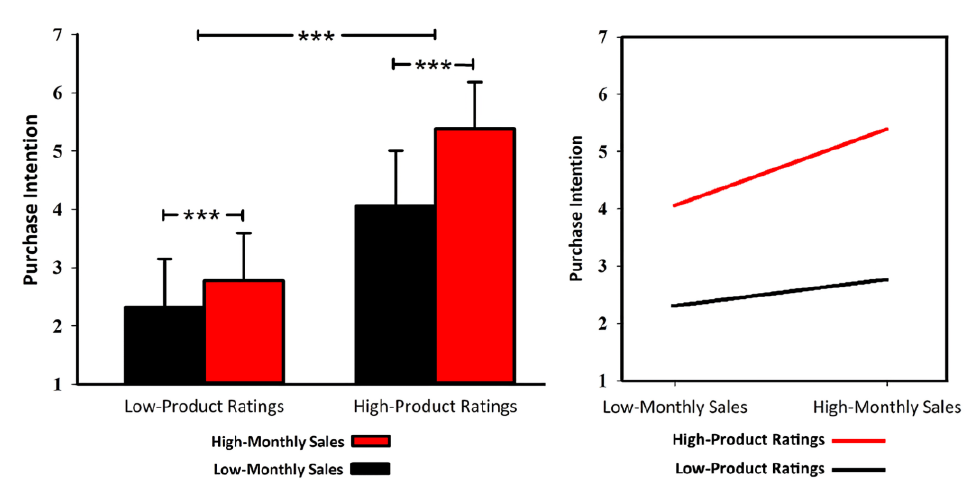
Figure 2. ANOVA and simple effect test results of behavioural data. Note: *** p < 0.001.